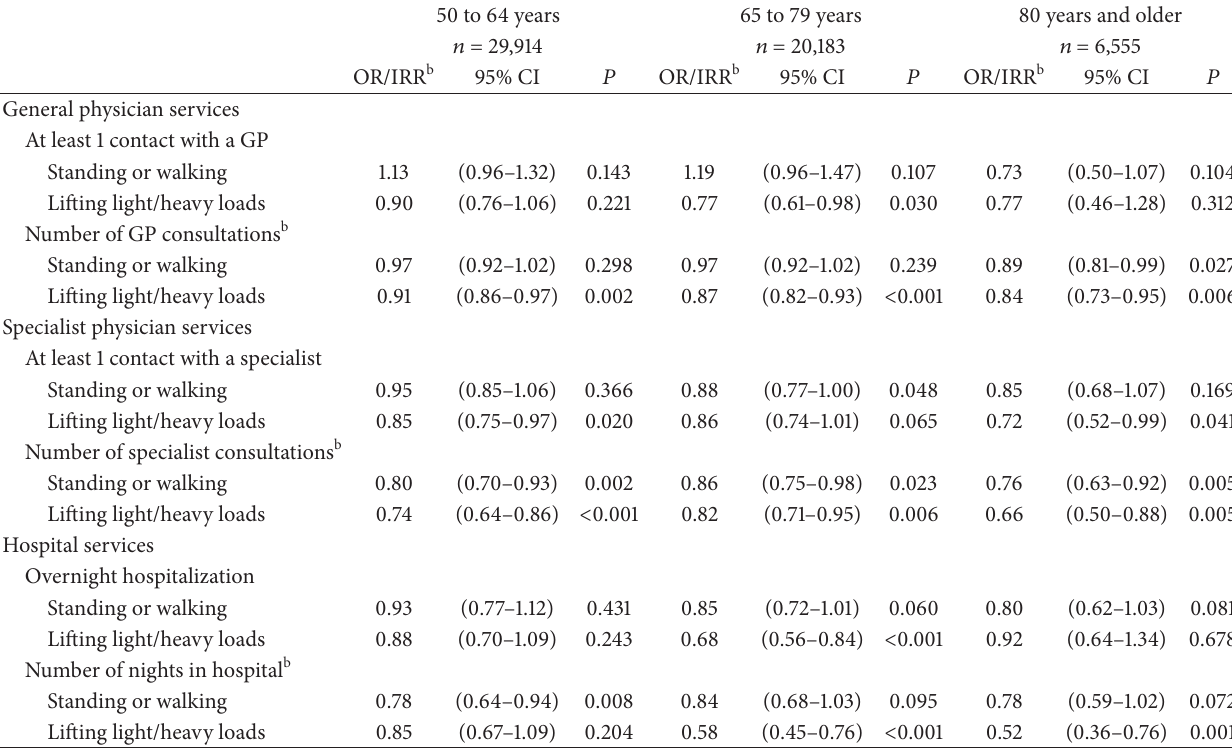
Table 7: The association between differing levels of typical daily activity a and health services utilization, stratified by